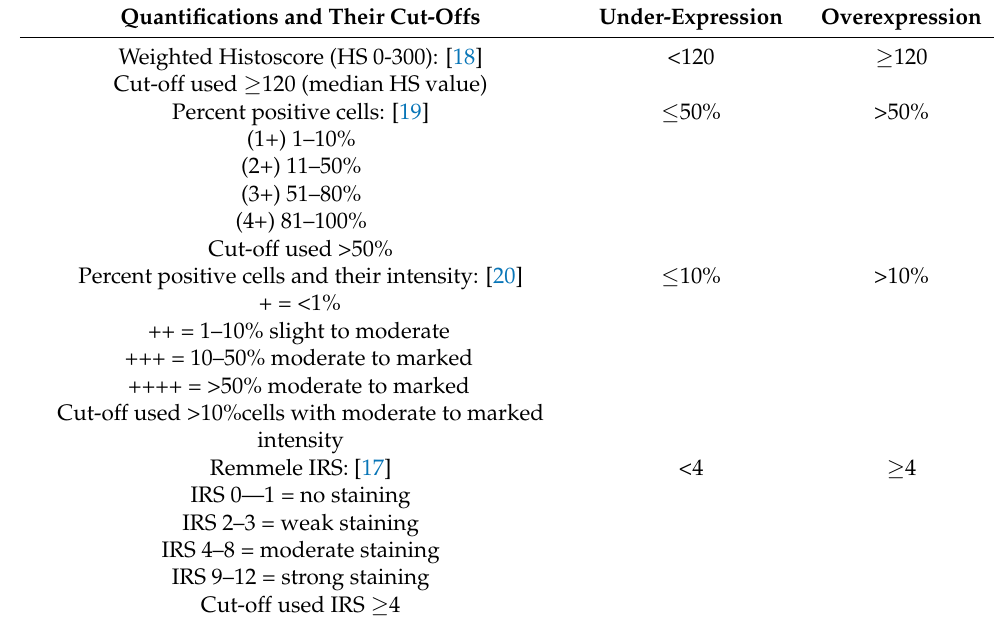
Table 2. The four quantifications and their set cut-offs used for HIF-1 α scoring and data analysis. Quantifications and Their Cut-Offs Under-Expression Overexpression Weighted Histoscore (HS 0-300): [18] <120 ≥